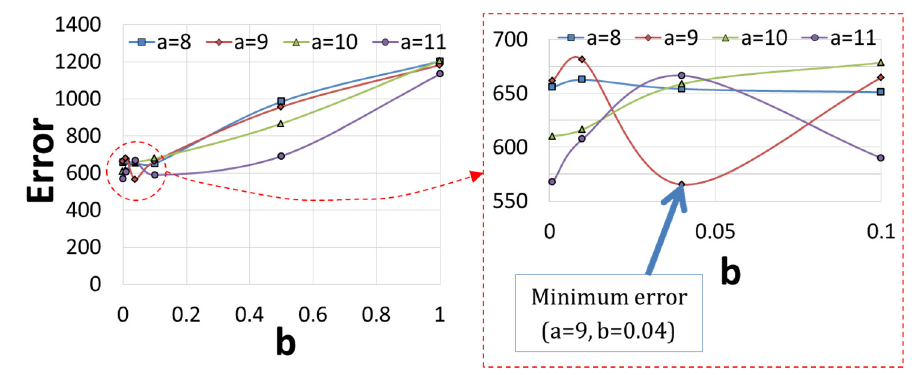
Figure 6. The variations of the objective function with respect to a and b .